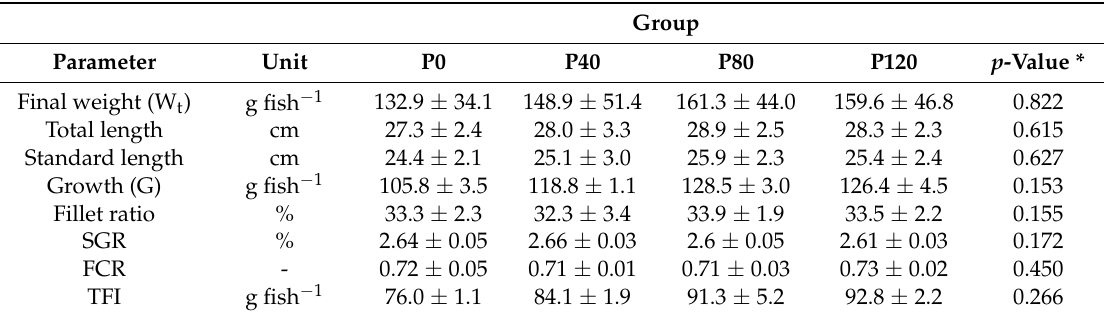
Table 2. Fish growth and feed efficiency of C. gariepinus (mean ±